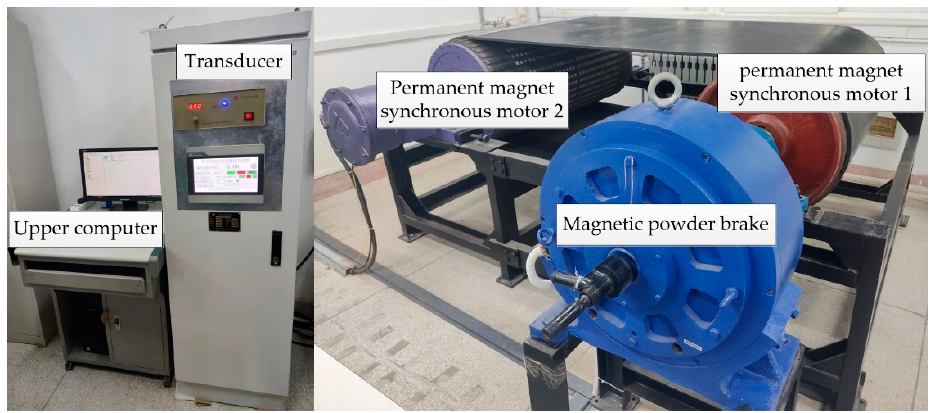
Figure 18. Experimental platform of the belt conveyor.